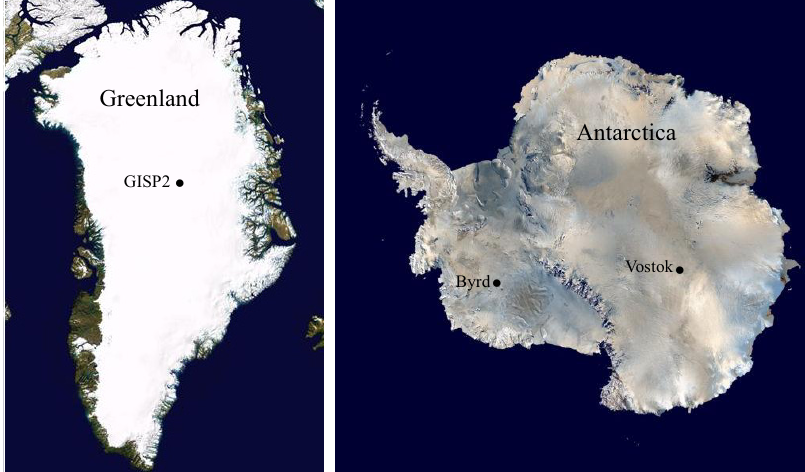
Figure 1. Locations of ice core sections used in this study. Sections from the Greenland Ice Sheet Project 2 (GISP2) (Greenland), Byrd (Antarctica) and Vostok 5G (Antarctica) ice cores were examined. See Experimental Section for more details about the core